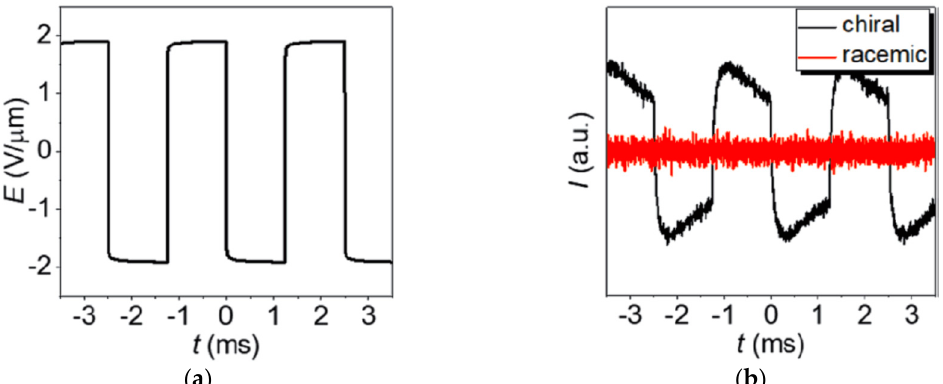
Figure 24. Electroclinic electro-optic effect of a chiral lamellar 𝛼 -phase in the vicinity to its transition into a tilted lyo-SmC* phase. ( a ) Square-wave electric field E( t ) applied to lyotropic L 𝛼( * ) samples in a direction normal to the layer normal k . ( b ) Corresponding electro-optic response of the lyotropic samples between crossed polarizers measured by the transmitted light intensity I ( t ) at a temperature of 0.2 K above the transition into the tilted phase; black line: chiral L 𝛼 * phase of 4 with 23 wt% of formamide; red line: nonchiral L 𝛼 phase of racemic 4 with 23 wt% of formamide. (Reprinted by permission from [69] Copyright 2018 by the American Physical Society.)